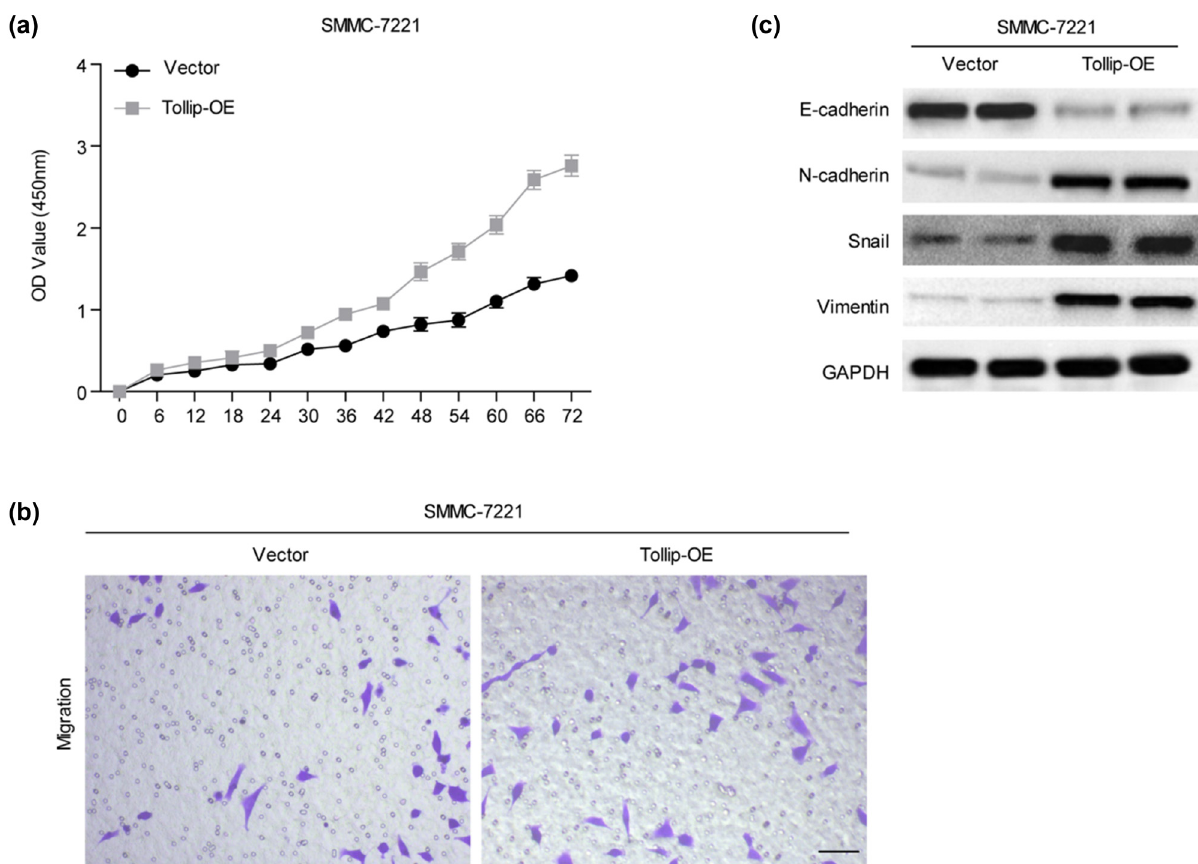
Figure A2: Tollip enhanced proliferate, migratory and metastatic capacities of SMMC - 7221 cells. ( a ) Assessment of the in fl uence of Tollip overexpression on SMMC - 7221 proliferation tested by CCK - 8 at the indicated time. ( b ) Evaluations of the in fl uence of Tollip - OE on migration activities of SMMC - 7221 by transwell migration assays. n = 5 fi elds per experimental group. ( c ) Expressions of EMT - related markers in SMMC - 7221 cell infected with overexpression of Tollip by western blot assays. n = 3 independent experiments. * p < 0.05 compared with control group.